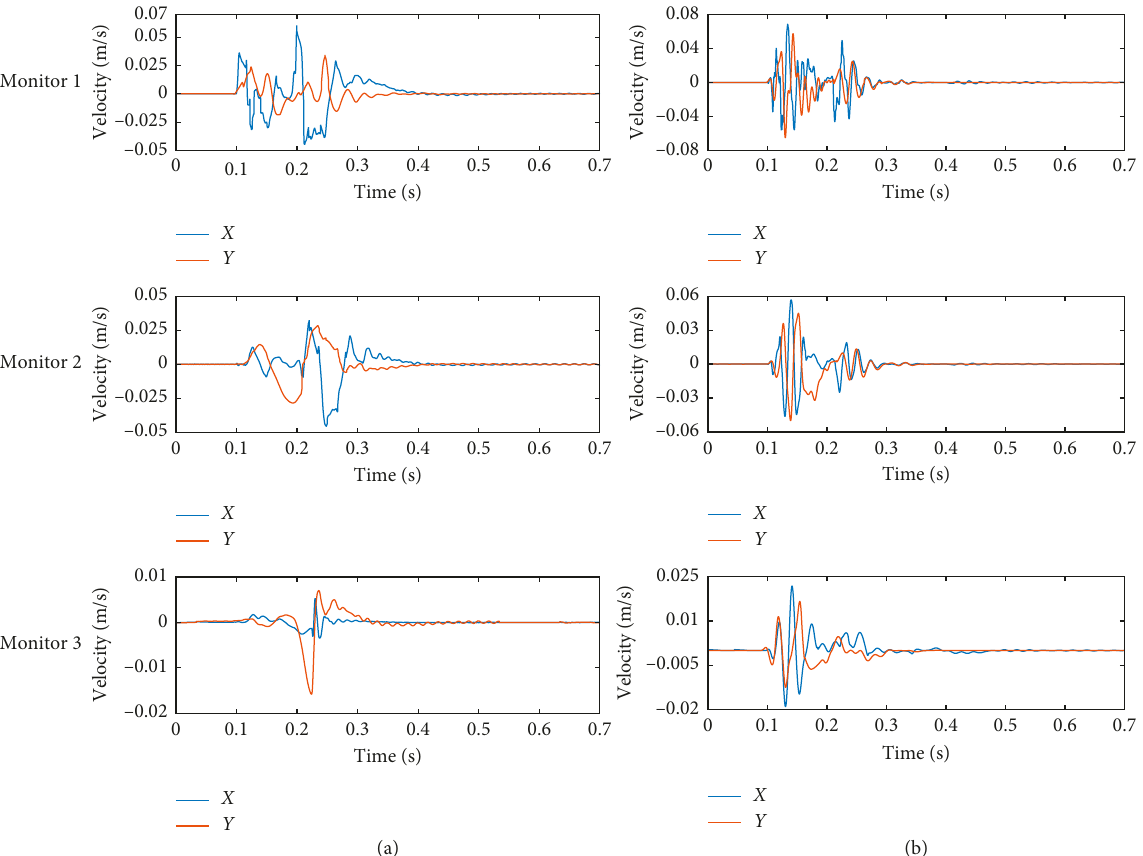
Figure 4: The vibration signals induced by the excavation of rock wells with (a) presplit blasting and (b) smooth blasting. X and Y represent radial and tangential directions,